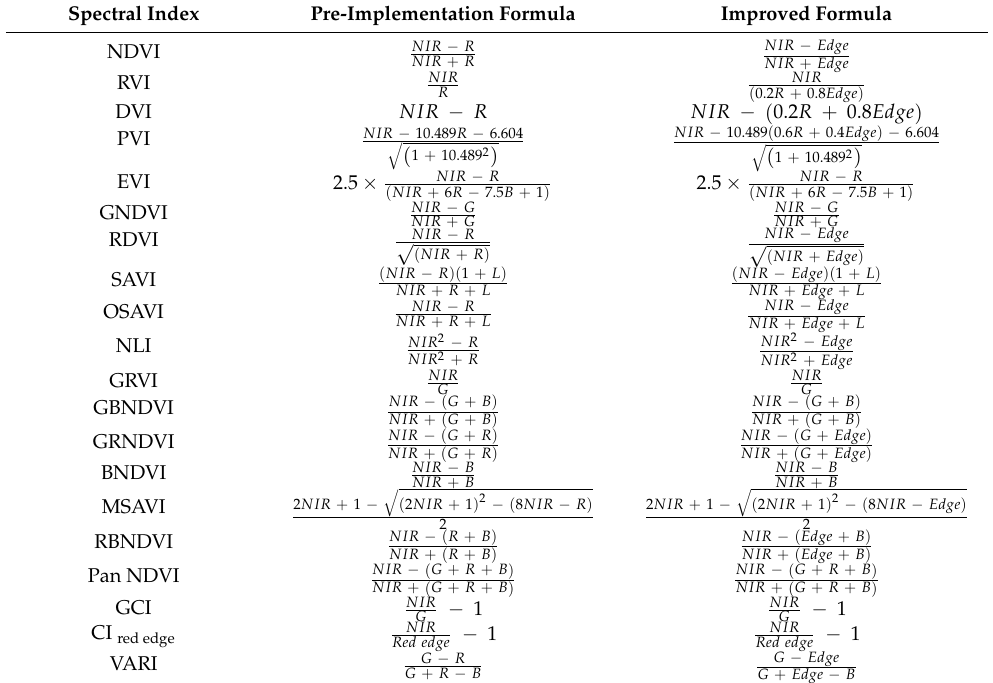
NIR : near-infrared band; Edge : red-edge band; R : red band; a : optimization coefficient. Table 1. Calculation formulae of spectral index. Spectral Index Pre-Implementation